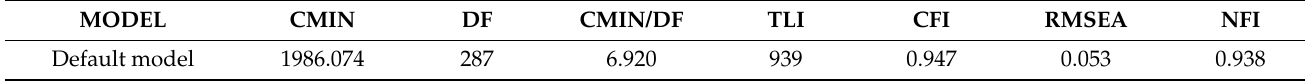
Table 4. Structural model